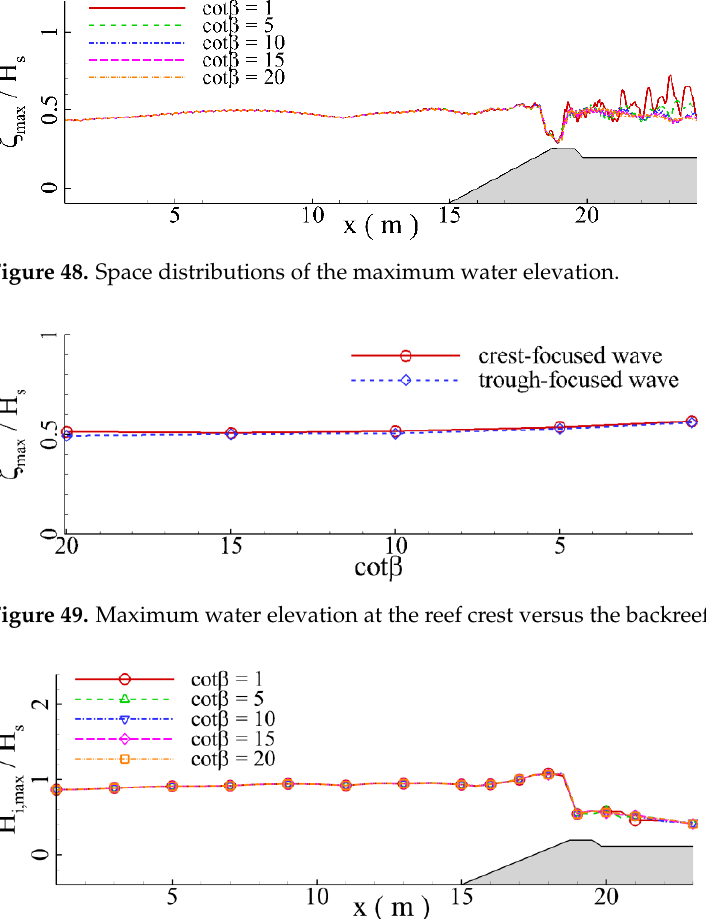
Figure 50. Space distributions of the maximum local wave height.